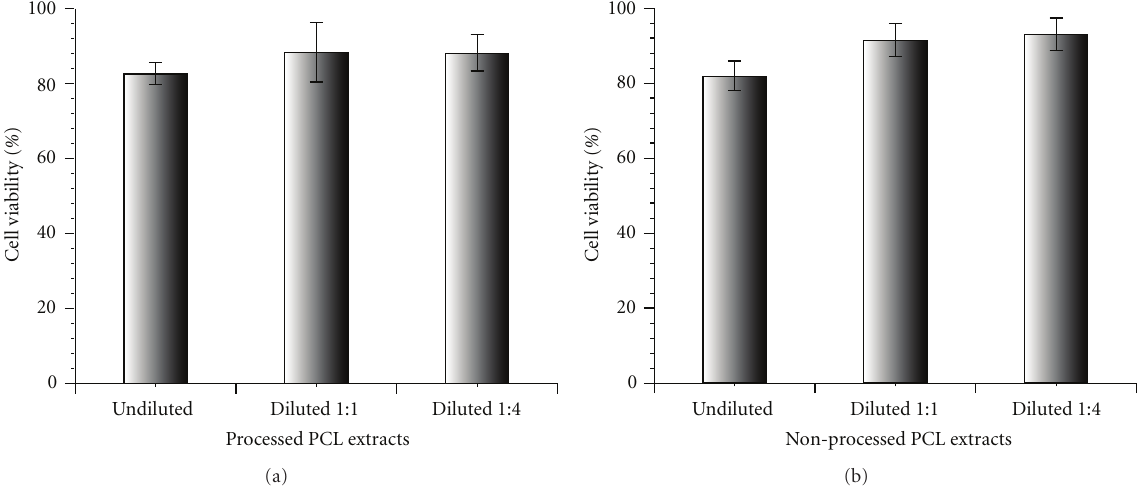
Figure 7: WST-1 cell proliferation assay performed on PCL extracts in solution with 3T3/A31 fibroblasts: (a) processed PCL extracts; (b) nonprocessed PCL